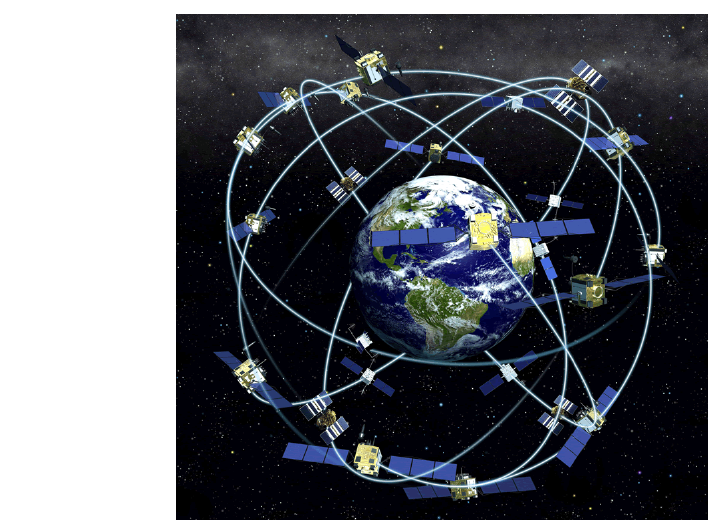
2 dat je raspored satelita koji kruže oko Zemlje.